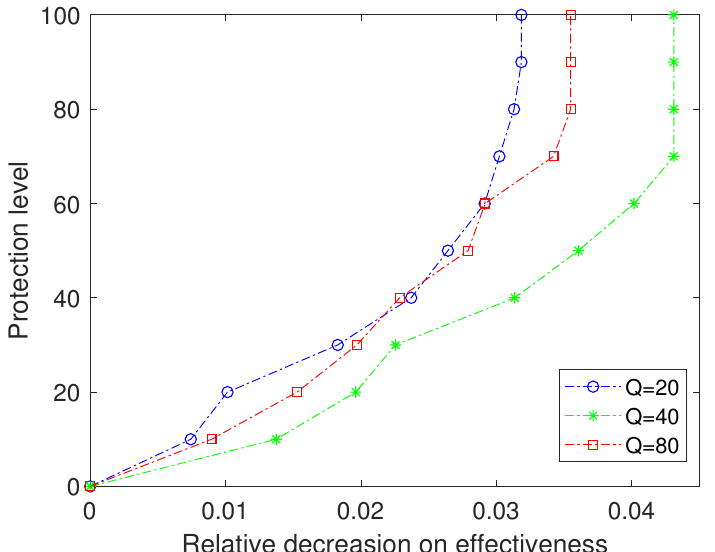
Figure 3. Protection level vs. relative decrease in